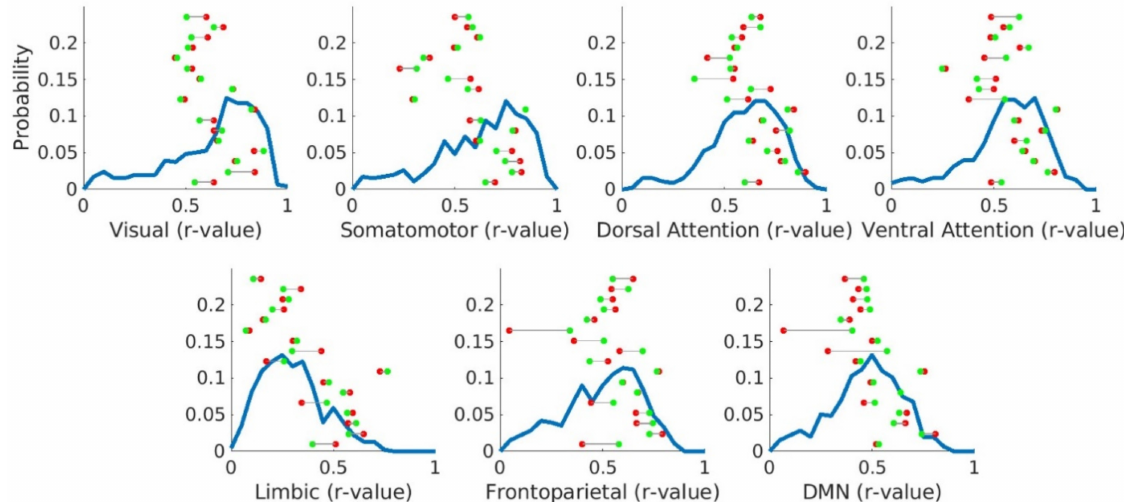
Figure 6. Average correlation within canonical networks in HCs and brain tumour patients before surgery. Blue lines represent the distribution of the average correlation within each of the 7 canonical networks for 653 HCs. Individual points illustrate the within-network correlation for each brain tumour patient when considering the hemisphere containing the tumour (red points) and the hemisphere contralateral to the tumour (green points). The Y -axis represents probability values only for HCs, not for the individual